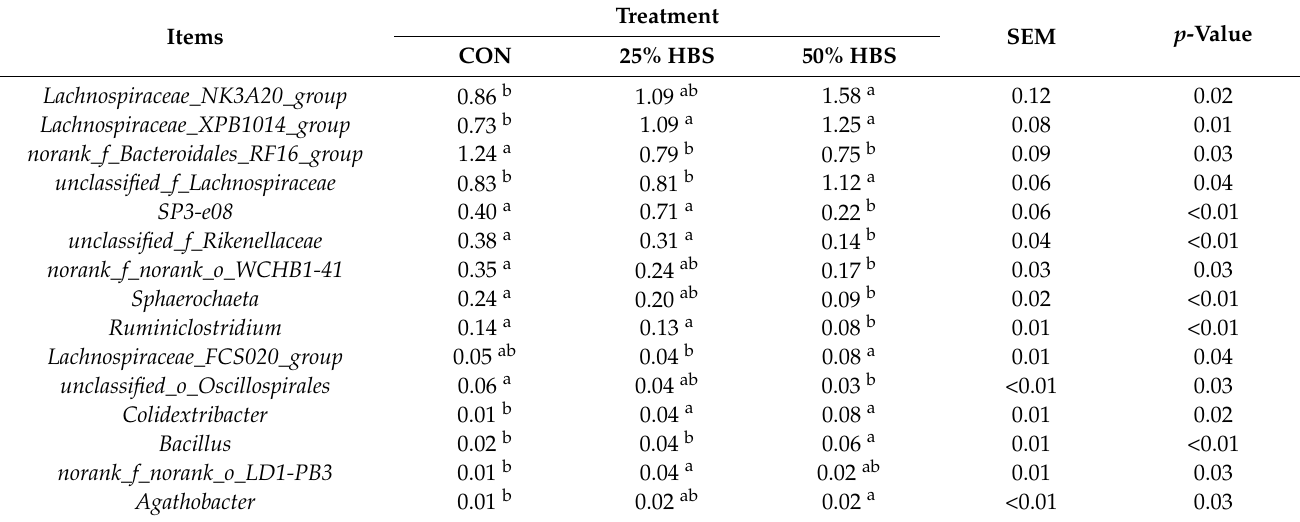
Table 5. Effects of different proportions of hydroponic barley seedlings replacing oat hay on the mean proportions (%) on different general in the differential ruminal bacteria of